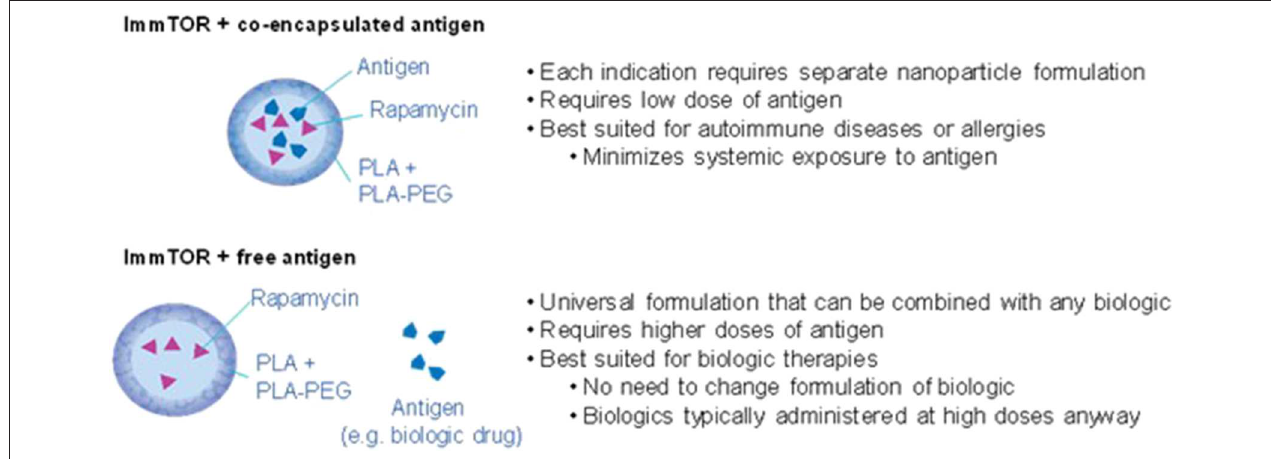
FIGURE 2 | ImmTOR with co-encapsulated antigen vs. ImmTOR + free